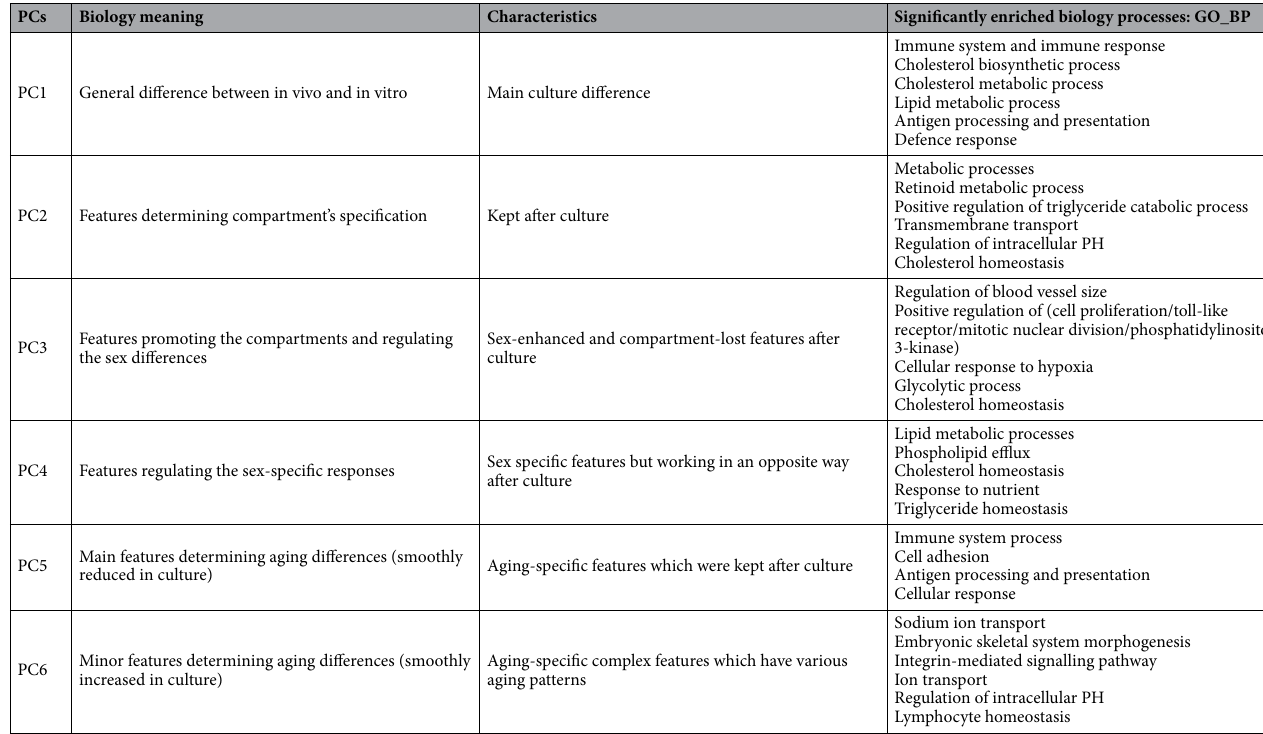
Table 1. Summary of PC1–PC6 on the indicated biology meaning, characteristics and biology processes enriched significantly from highly-contributing genes of corresponding principal